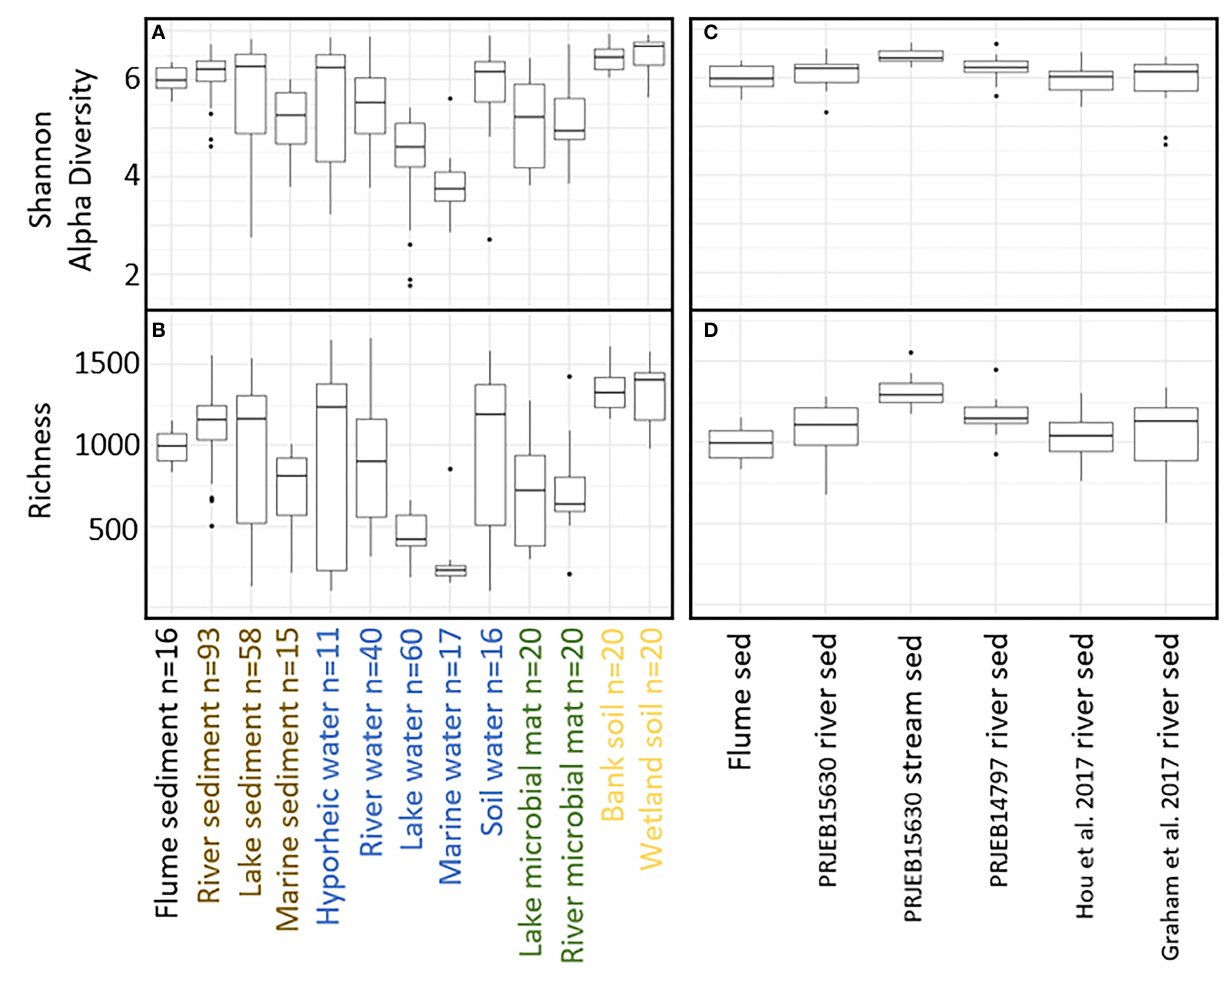
FIGURE 4 | (A) Shannon alpha diversity and (B) richness comparison between flume samples and natural samples. Sample biome/environment groups are color coded by environment with the exception of the flume environment, which is called out in black. (C) Shannon alpha diversity and (D) richness comparison between flume samples and natural river sediment